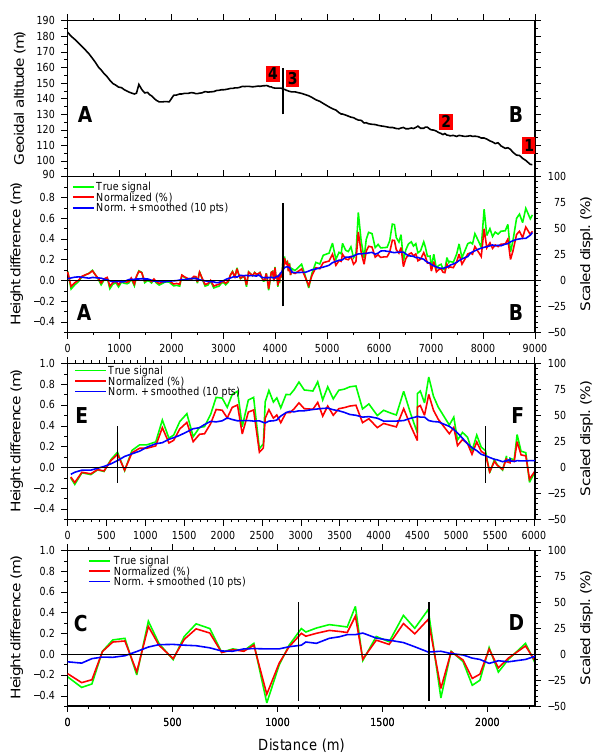
Figure 12. Difference in ice surface altitude between high and low tide for profile [AB], [EF] and [CD]. The green curve represent true GPS data difference, whereas the red one represents this difference scaled to the tidal amplitude (expressed as a percentage). The blue line is a smoothed version (over 10 points) of the red curve. Loca- tions where the altitude difference becomes significant are shown by the black vertical line and define our grounding line kinematic control points. The altitude above sea level for profile [AB] is also displayed at the top along with the positions of the four GPS drop points along the profile (see Sect.